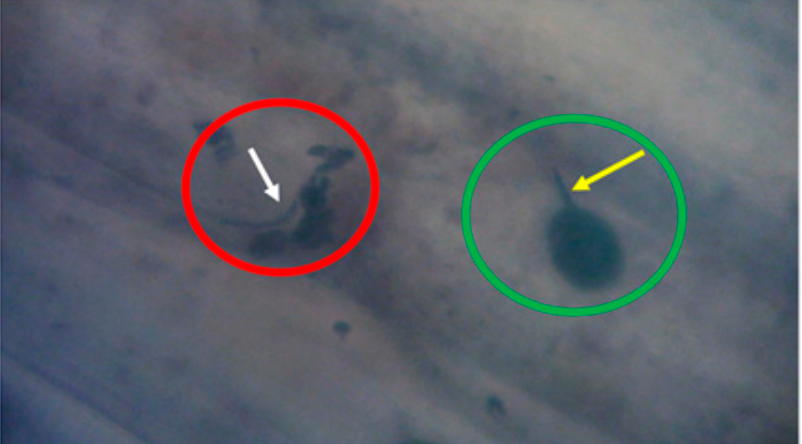
Figure 2. × 1000 magnification of Vicker’s ® microscope, from lab-controlled Zulu winter wheat growth showing AM fungal arbuscules (red), vesicle (green), peri arbuscular membrane (white arrow) and intracellular hyphae (yellow arrow). Imaged with a Bresser ® HD microscope camera and stained with Sheaffer ® blue